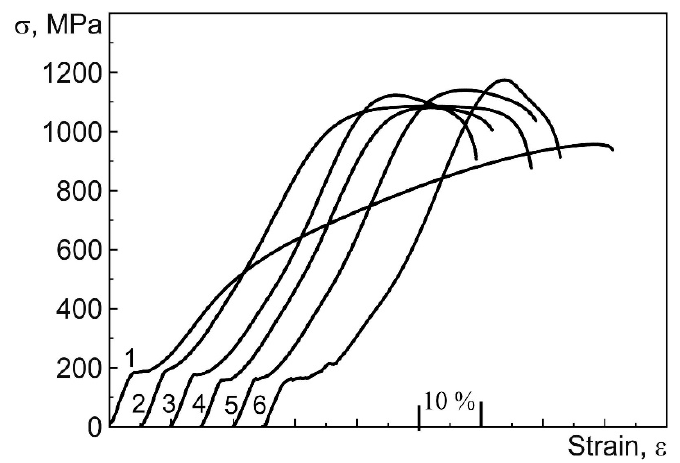
Figure 5. Engineering “stress–strain” curves during tension of titanium nickelide samples in the initial state (1) and after abc-pressing with e = 1.84 (2); 3.60 (3), 5.40 (4), 7.43 (5); 9.55 (6).